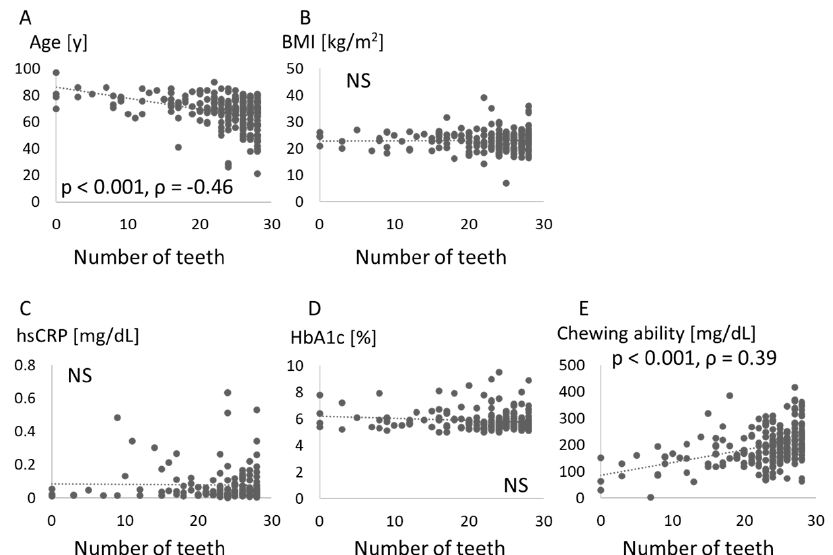
Figure 2. Association between each score and number of teeth. Age ( A ), body mass index (BMI) ( B ), high-sensitivity C-reactive protein (hsCRP) ( C ), hemoglobin (Hb)A1c ( D ), and chewing ability ( E ) are compared with number of teeth. NS: not significant.